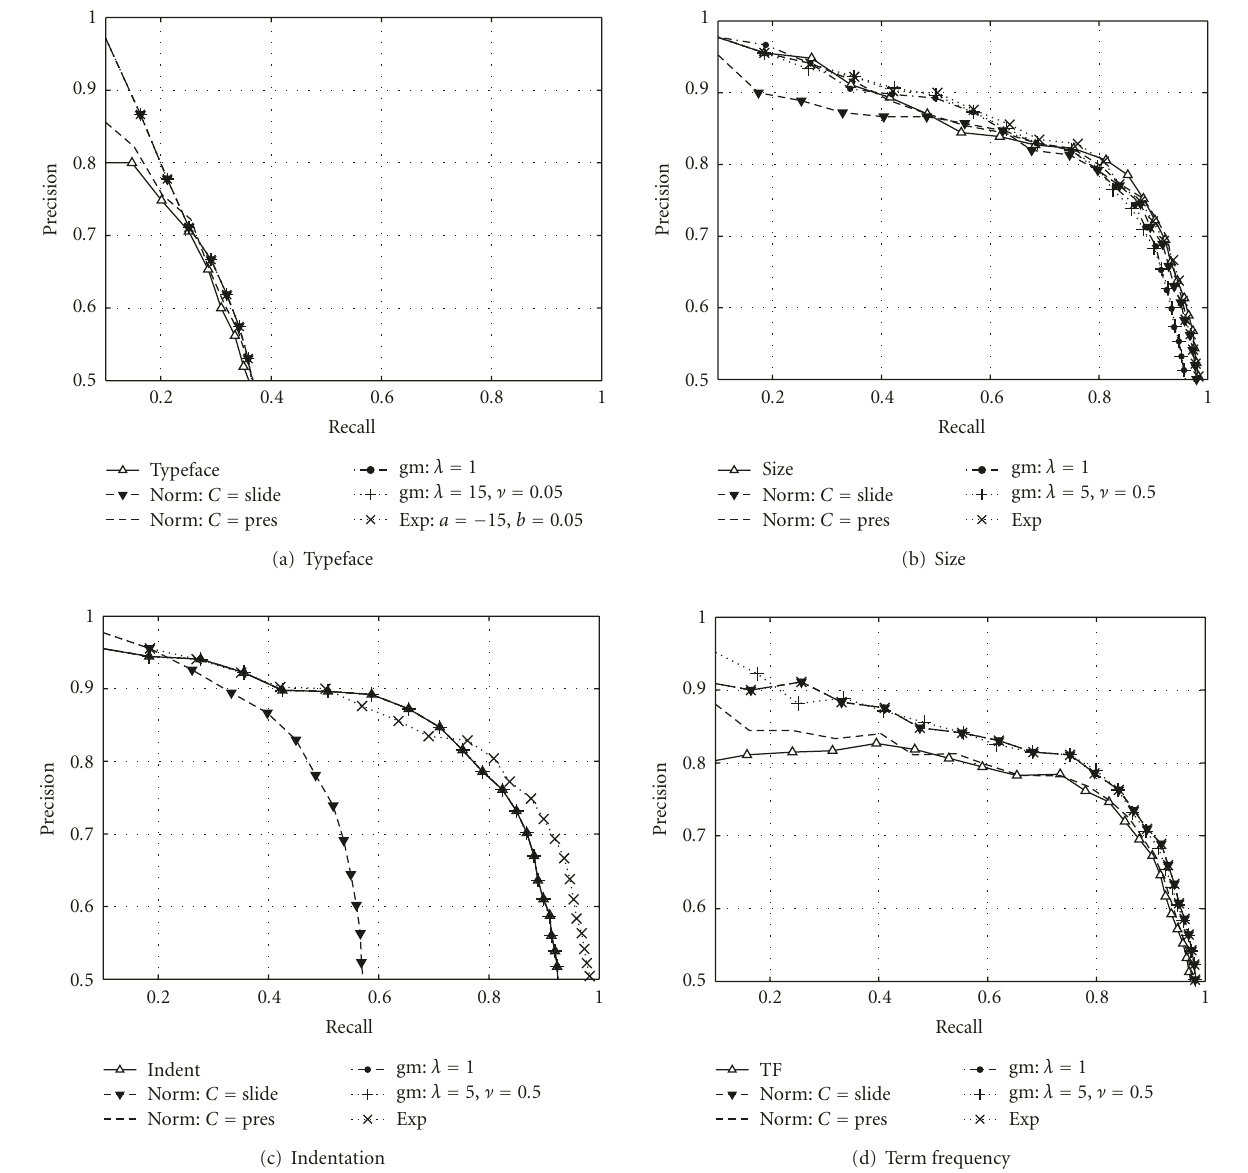
Figure 10: Precision-recall curves for various membership functions and context